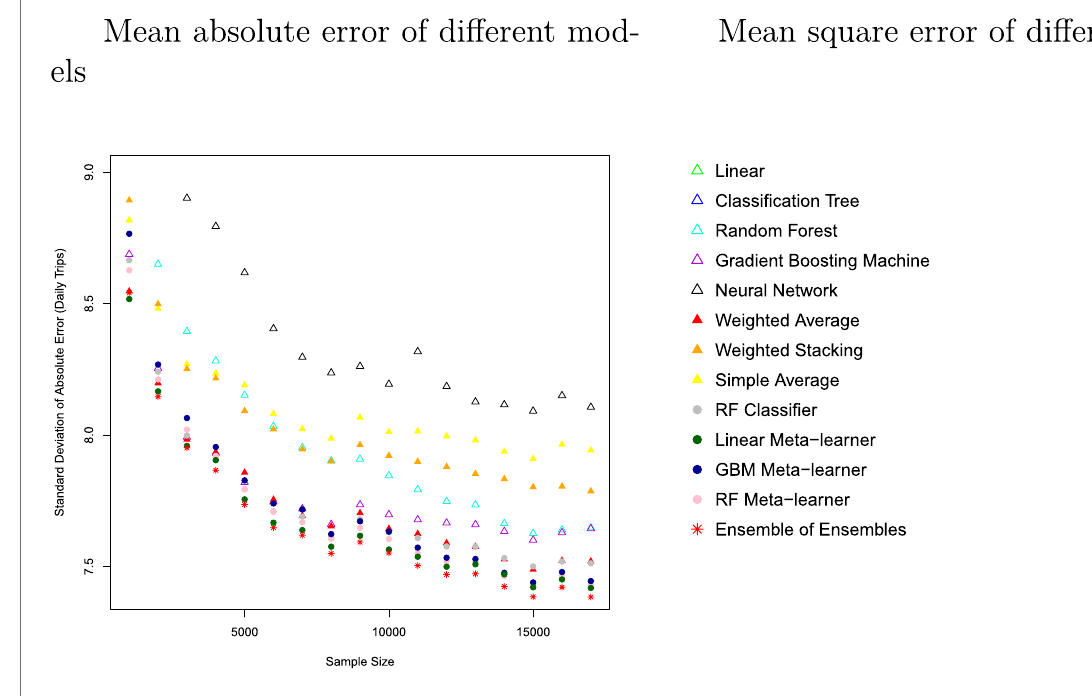
Frontiers in Future Transportation |